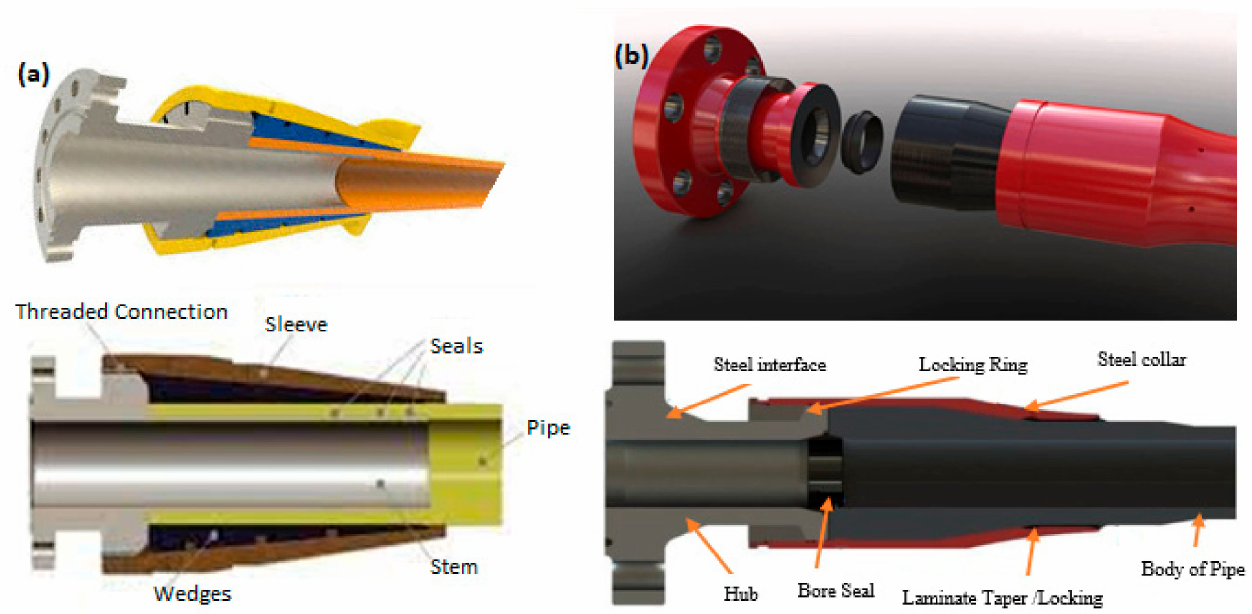
Figure 14. End-fitting designs for ( a ) Airborne end-fitting and ( b ) Magma end-fitting. (Permission to reuse was obtained by the industry designers—Airborne Oil and Gas for Image ( a ) and Magma Global for Image ( b